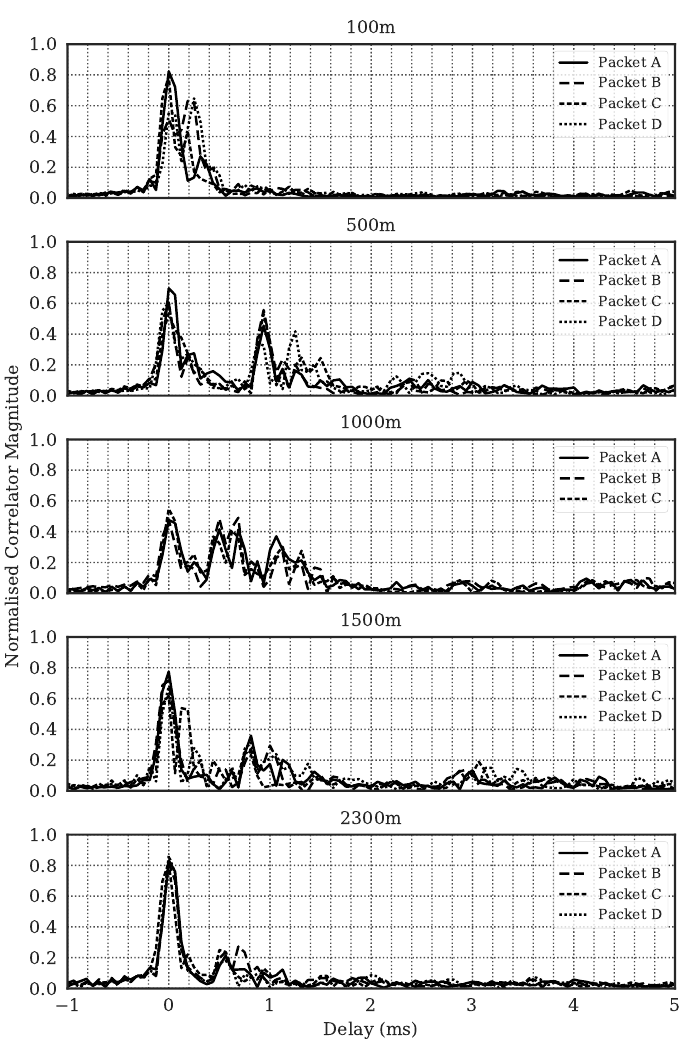
Figure 14. North Sea channel impulse responses for range